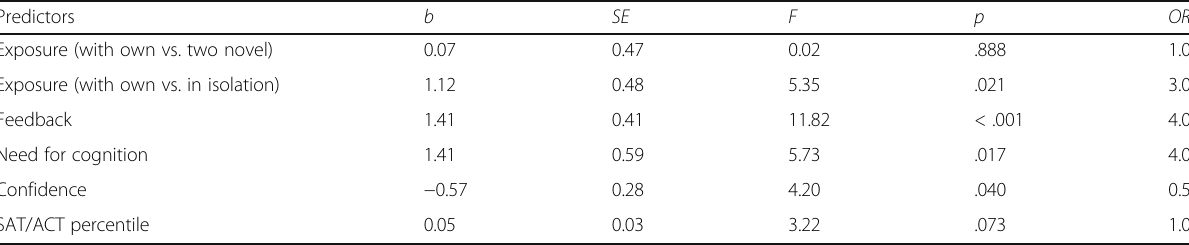
Table 1 Best-fitting model for predicting adoption of the area strategy in Study 1 Predictors b SE F p OR Exposure (with own vs. two novel) 0.07 1.07 Exposure (with own vs. in isolation) Feedback Need for cognition Confidence − 0.57 SAT/ACT percentile